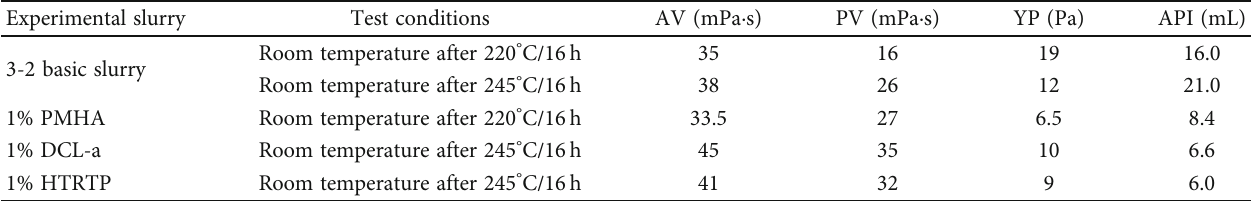
Table 6: Comparison of fl uid loss controlling of fl uid loss agents in weighted fresh water slurry.